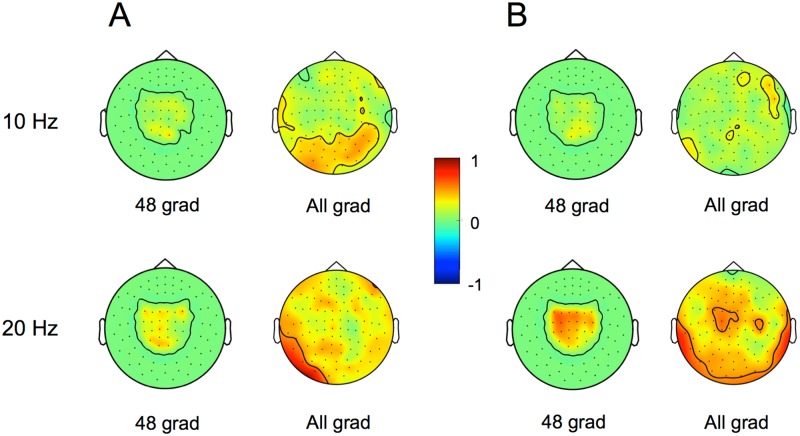
Correlations of classification performance and measures of 10/20-Hz activity at each gradiometer.Correlations between (A) left-vs-right and (B) MI-vs-rest cross-validated accuracy and 10/20-Hz suppression level at 48 parietal gradiometers (left) and all gradiometers (right). In the case of 48 gradiometers, the black contour lines show the outlines of non-zero correlation values.